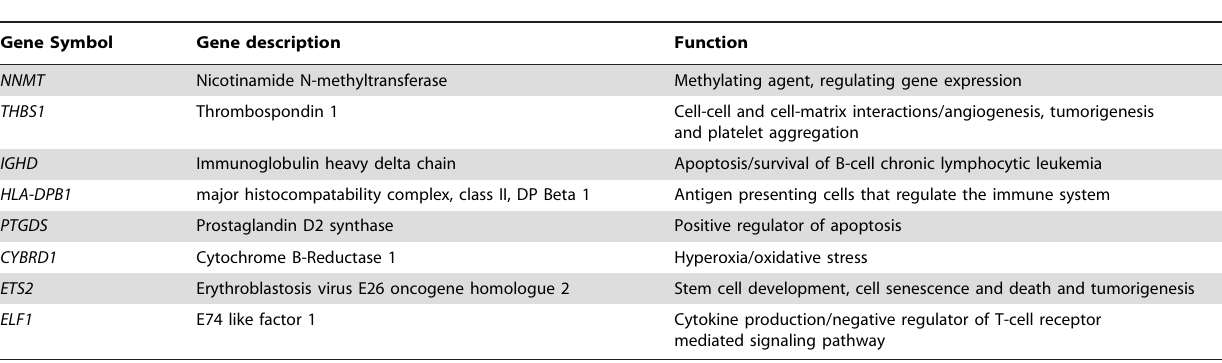
Table 2. List of the eight candidate genes and their